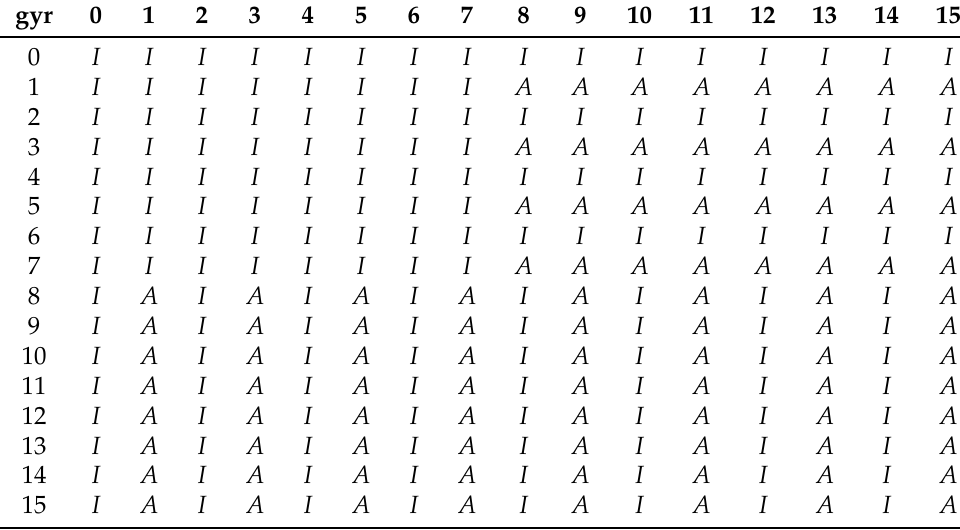
Table 3. The gyration table for the gyrogroup G ( 4 ) . The gyroautomorphism A is given in cycle decomposition by A = ( 8 12 )( 9 13 )( 10 14 )( 11 15 )